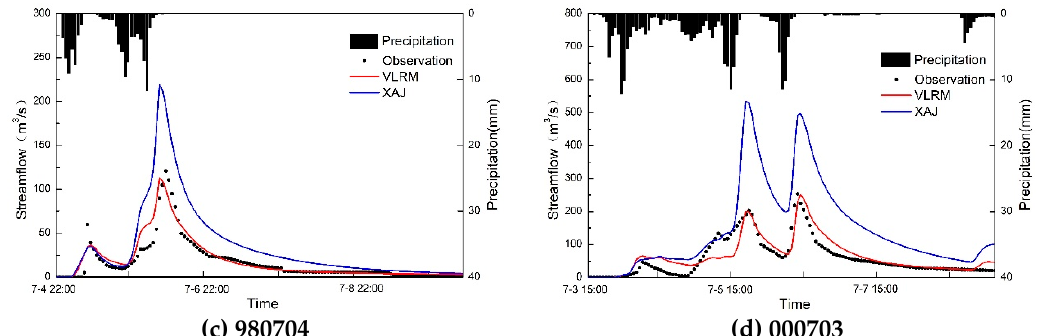
Figure 4. Comparisons of observed and simulated streamflow for typical flood events in Zijingguan basin in panels ( a ), ( b ) for calibration and ( c ), ( d ) for validation.